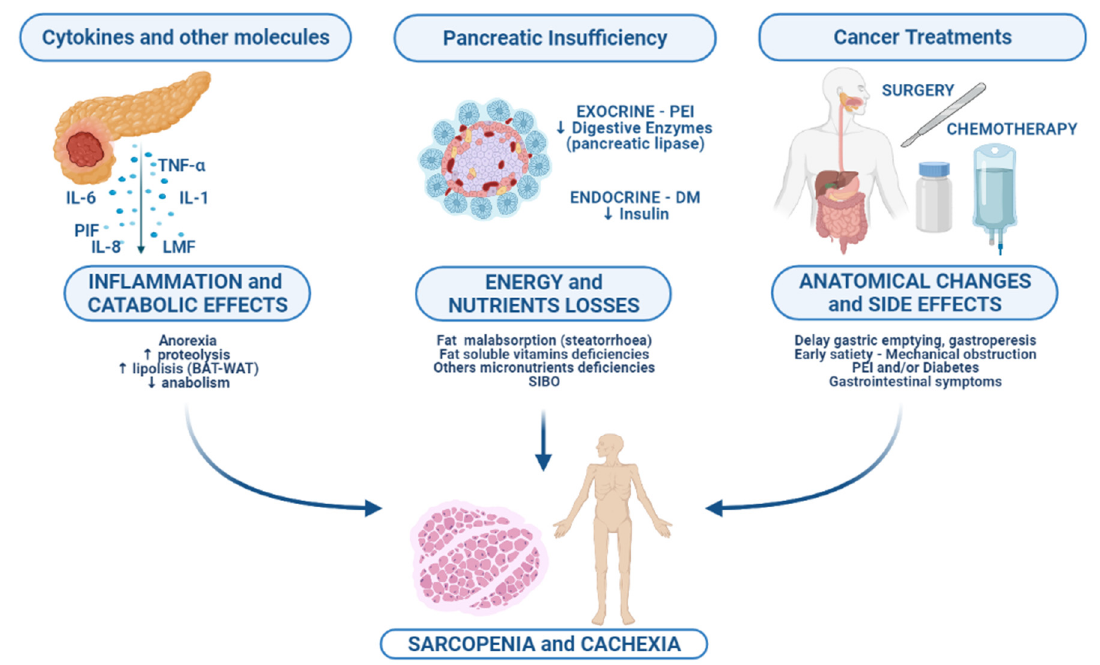
Figure 1. Multifactorial etiology of cachexia and sarcopenia in pancreatic cancer patient. Abbreviations: PIF, proteolysis- inducing factor; LMF, lipid mobilizing factor; BAT, brown adipose tissue; WAT, white adipose tissue; PEI, pancreatic exocrine insufficiency; DM, diabetes mellitus; SIBO, small intestinal bacterial overgrowth.